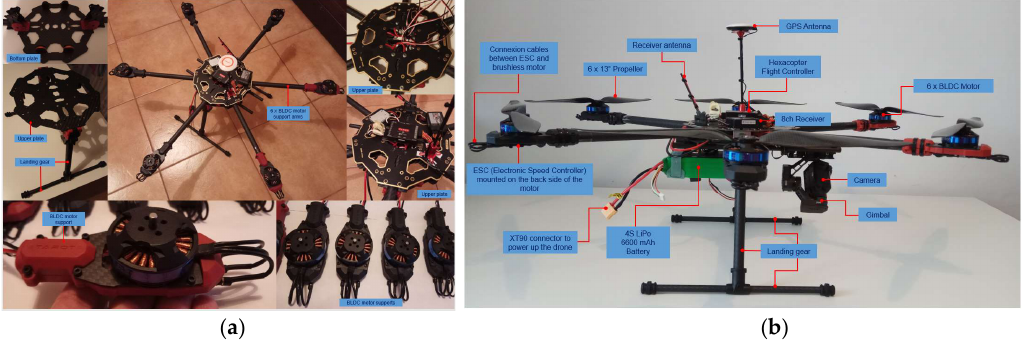
Figure 3. Hexacopter variant v1. ( a ) Components; ( b ) Assembly.